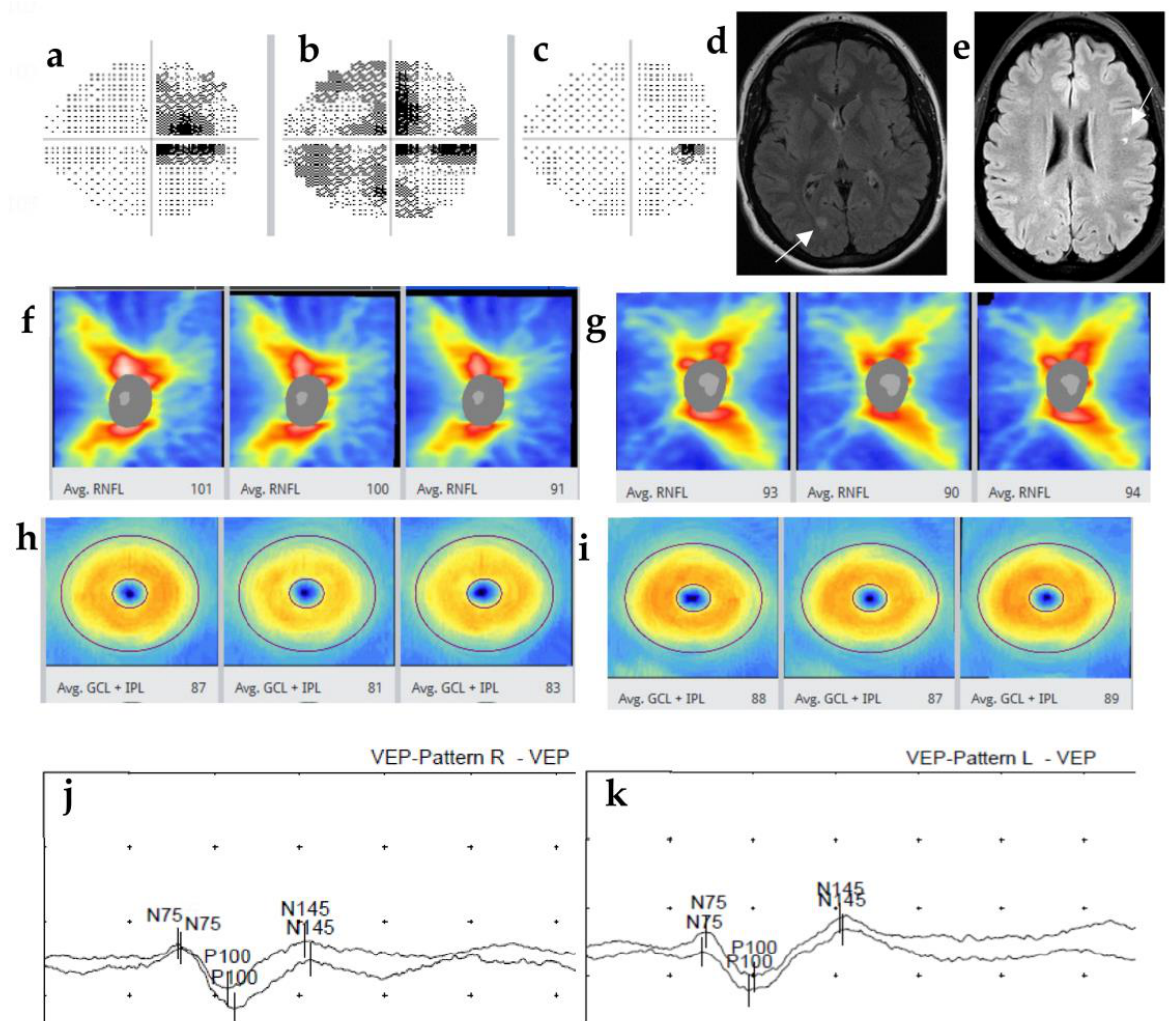
Figure 1. A 34-year-old woman with right side atypical optic neuritis (ON) at onset and who developed multiple sclerosis (MS) four years later. Status demonstrated with visual field (VF) test, optical coherence tomography (OCT) and visual evoked potentials (VEP). VF test showed superior quadrantanopia in the right eye at day 1 ( a ), central and peripheral VF defect at day 7 ( b ), but normalized at 2 months ( c ). MRI showed a T2 FLAIR lesion in the right occipital lobe at onset ( d ) and a juxtacortical lesion in the U fibers on the left side ( e ) 4 years later. OCT thickness map showed normal but asymmetric thickness of RNFL ( f , g ) and normal GCIPL ( h , i ) in both eyes at day 7 and week 8, but with thinning in RNFL (from 100 to 91 µm) and GCIPL (from 87 to 83 µm) in the right eye, and stable in the left eye at 5 months’ follow -up. VEP showed delayed latency of P100 in the right eye and normal in the left eye (right 111, left 101 ms) ( j , k ) at the onset which remained unchanged at 5 years’ follow -up.